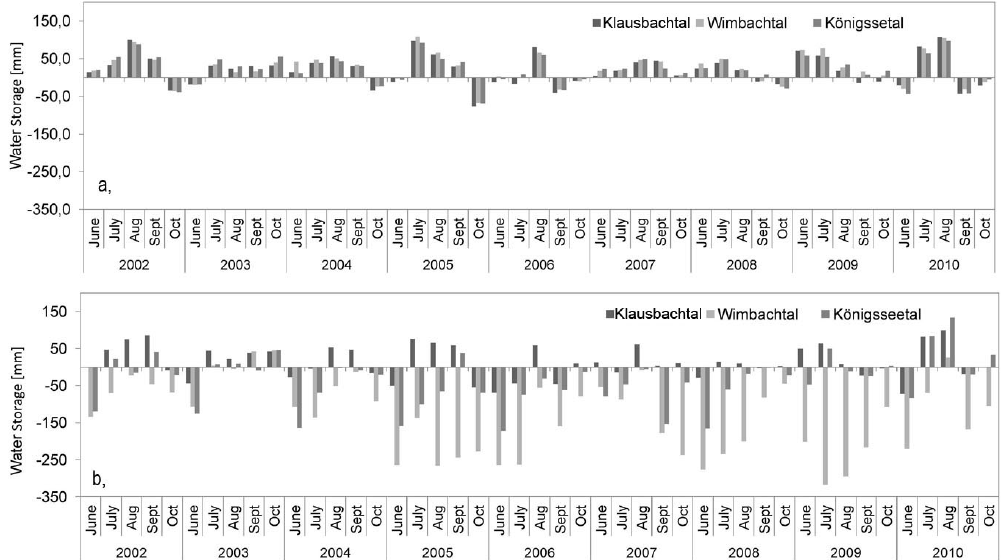
Fig. 8. (a) Comparison of the water storage ( S mod ) derived from results of hydrological model runoff before ANN correction. Monthly